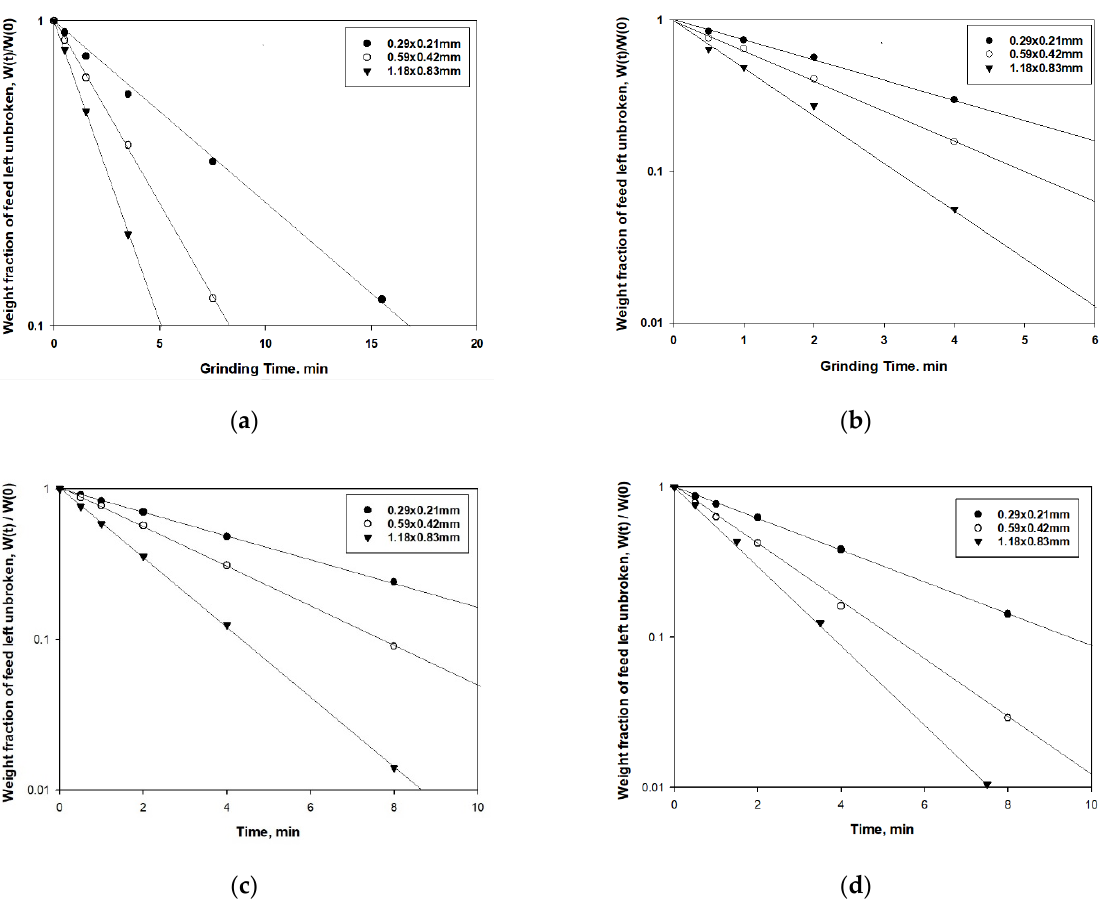
Figure 3. First-order plots for batch grinding of single-sized feeds: ( a ) Molybdenum (dry), ( b ) molybdenum (wet), ( c ) uranium (dry), and ( d ) uranium (wet).